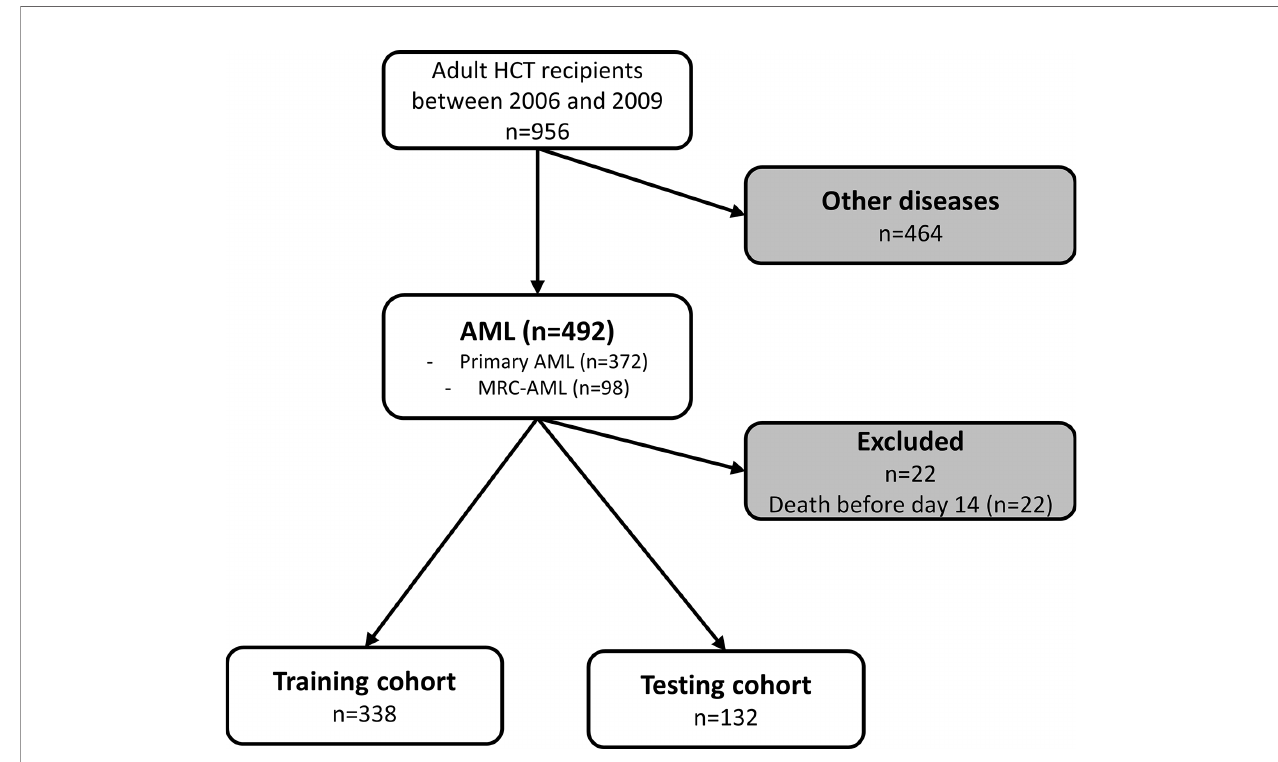
FIGURE 1 | Flow chart of patients included in the study. AML, acute myeloid leukemia; HCT, hematopoietic cell transplantation; MDS, myelodysplastic syndrome; MRC, myelodysplasia related